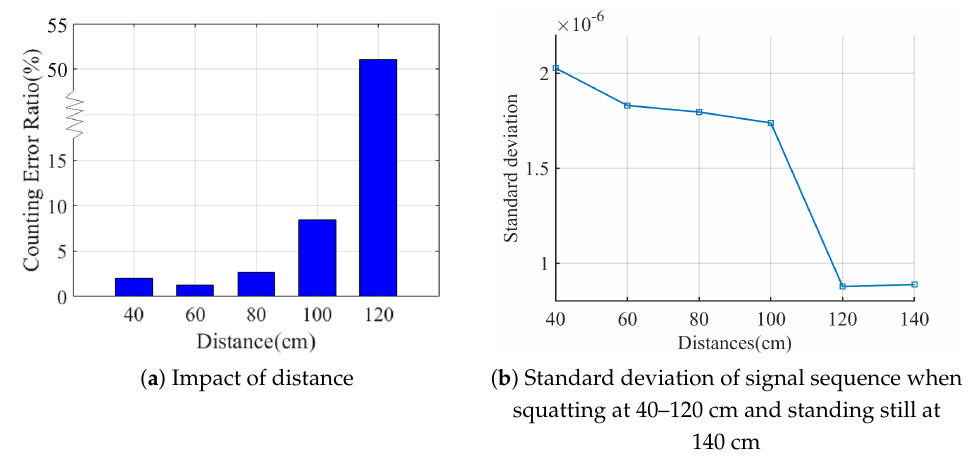
Figure 21. Impact of different distances and